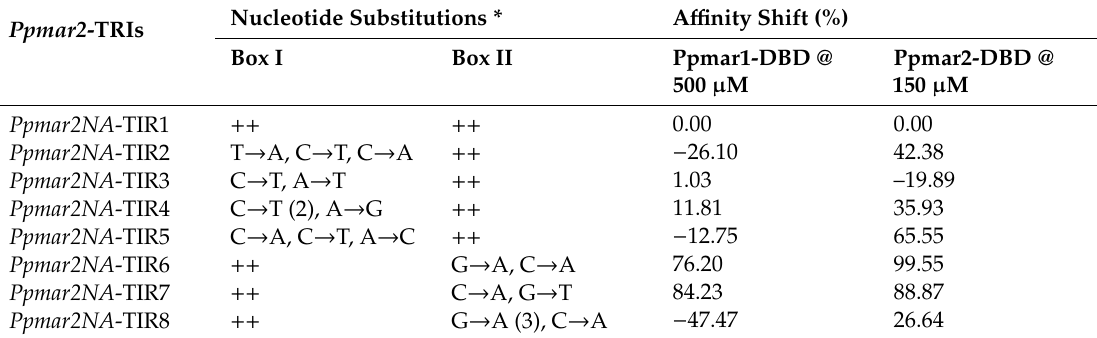
Table 2. The details of the Ppmar2NA -TIRs interaction with di ff erent concentration of Ppmar2 -DBD and Ppmar1 -DBD